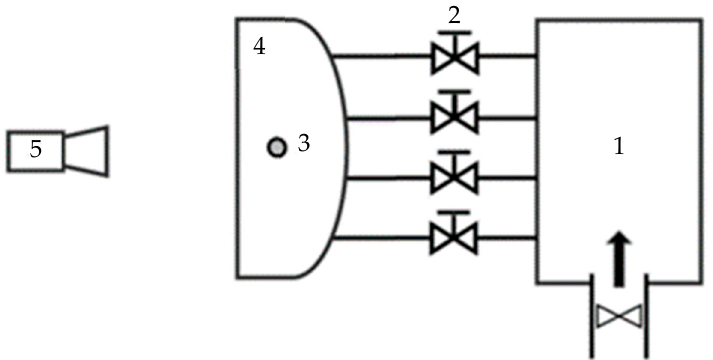
Figure 1. Schematic of the test rig (1: pressurized air; 2: regulators; 3: humidifier; 4: headlamp; 5: camera).